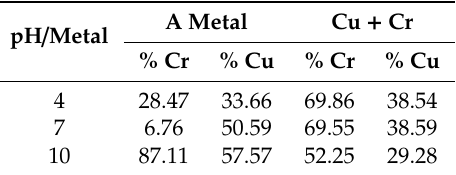
Table 2. Removal percentage when the solution only have a metal (A) and when the two metals are simultaneously in solution (Cu + Cr).